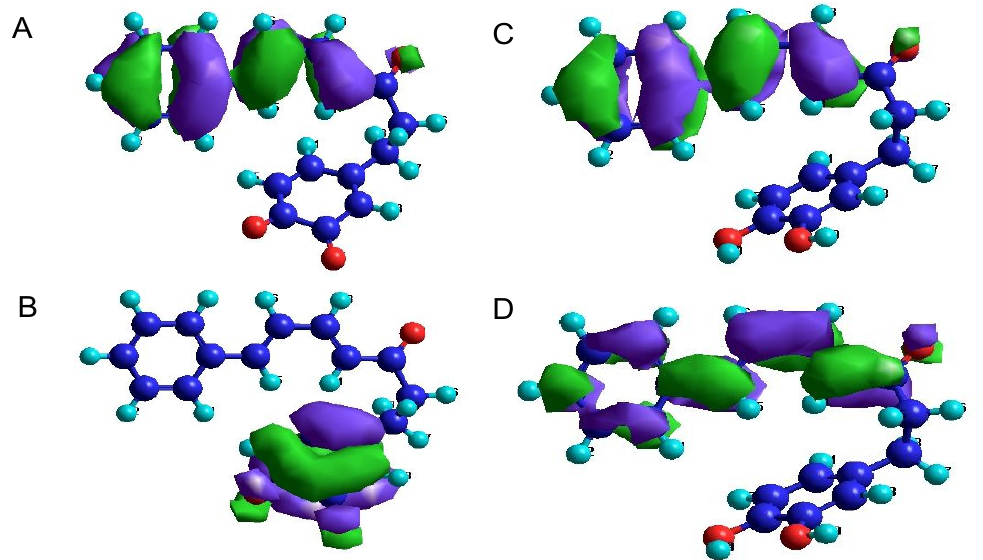
Figure 4. ( A ) HOMO and ( B ) LUMO of compound 1c and ( C ) HOMO and ( D ) LUMO of compound 1a